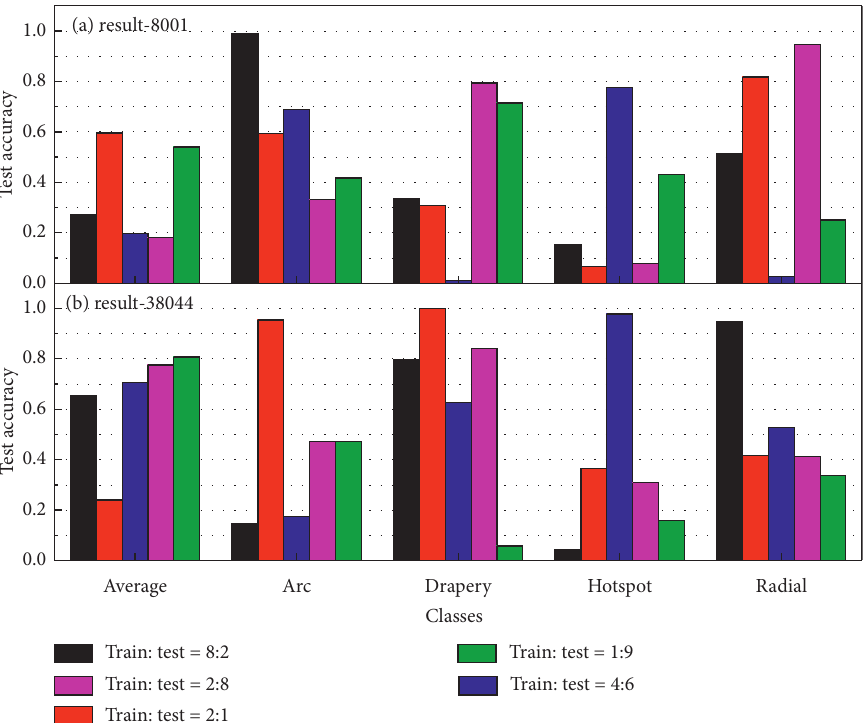
Figure 6: (a) 8001 database and (b) 38044 database.